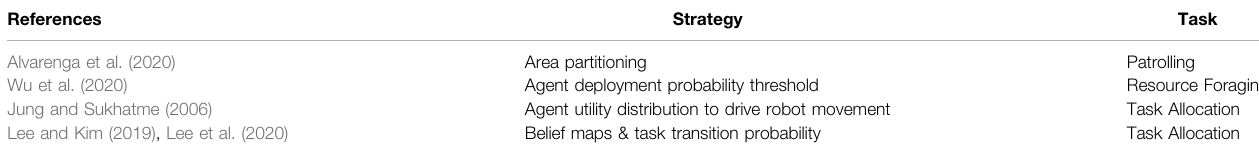
TABLE 7 | List of works using agent area and task assignments to in fl uence the level of exploration and exploitation of an